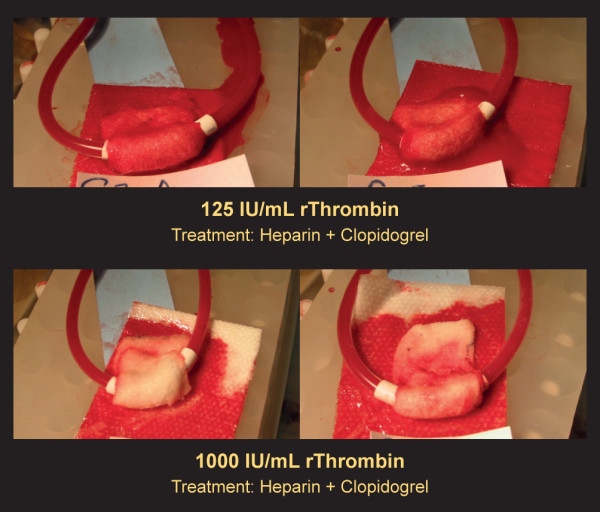
Clot burst assessment of AV shunt grafts treated with different concentrations of rThrombin. Rabbits were treated with heparin + clopidogrel. The grafts were wrapped with AGS containing either 125 IU/mL rThrombin (top row) or 1000 IU/mL rThrombin (bottom row). After hemostasis was achieved, blood flow was clamped for 10 seconds, and clot burst was assessed. Images were obtained after the 10 second assessment period. Upper images show sponge saturation and bleed-thru in representative grafts whose hemostasis did not survive clot burst challenge (125 IU/mL rThrombin; 11 of 14 grafts ruptured [79%]). Lower images show representative grafts that maintained hemostasis following clot burst challenge (1000 IU/mL rThrombin; 0 of 14 grafts ruptured [0%]). In the placebo group, most grafts did not maintain hemostasis (8 of 10 grafts ruptured [80%]; data not shown).